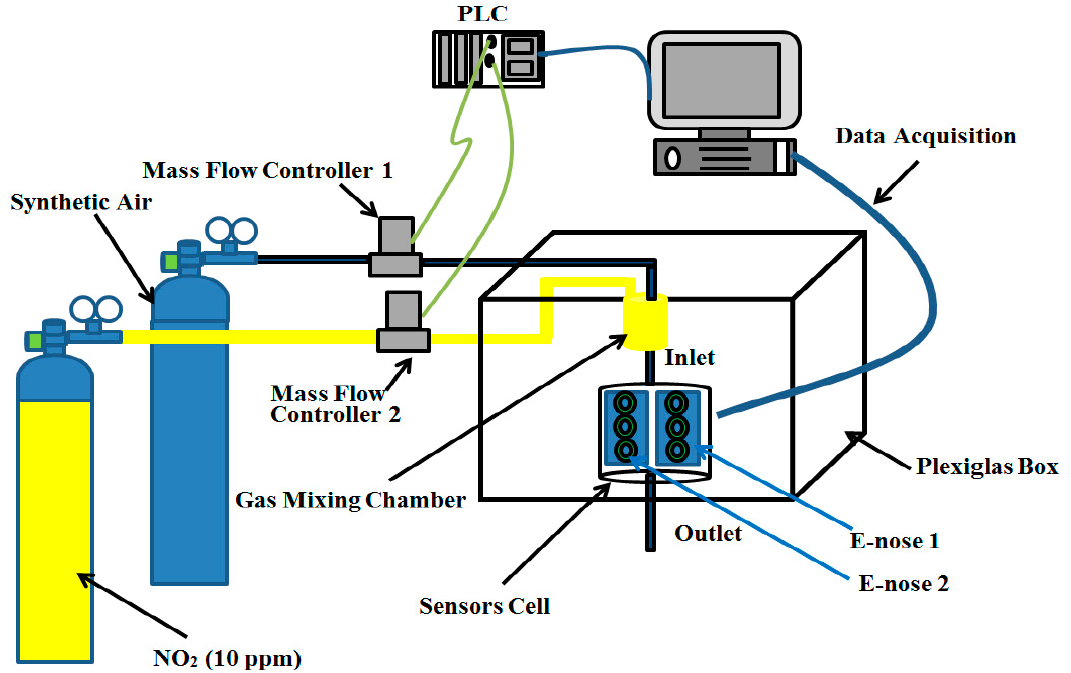
Figure 1. Schematic representation of the experimental setup. NO 2 : nitrogen dioxide.